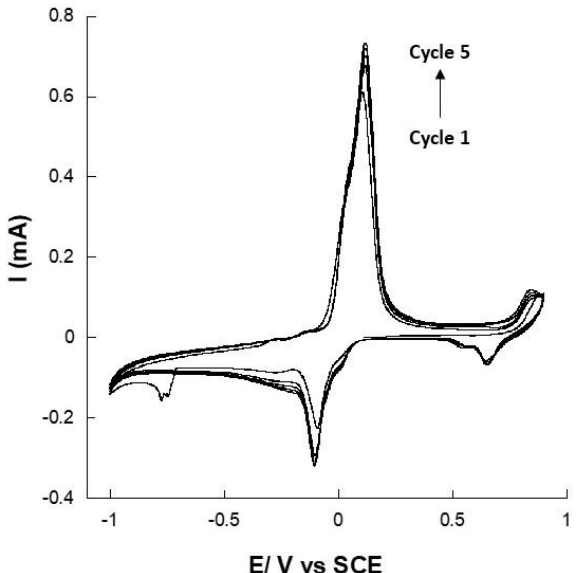
Figure 3. Consecutive cyclic voltammograms at 10 mV · s − 1 of methylene green (MG) electropolymer- ization on a gold electrode in pH 7 PBS containing 5.0 × 10 − 4 M MG (5 cycles).